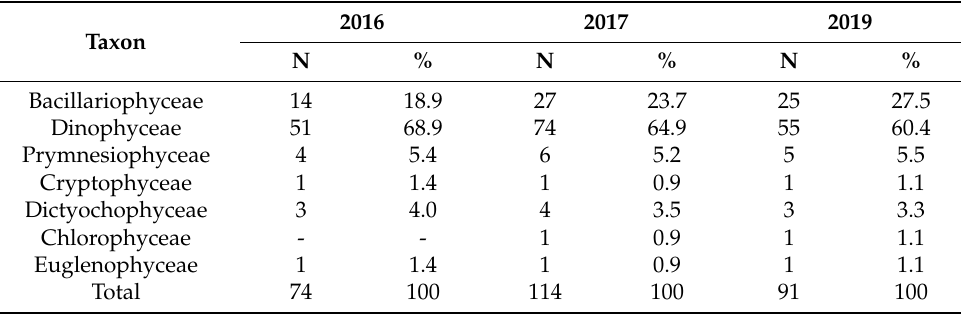
Table 1. Taxonomic composition of phytoplankton abundance